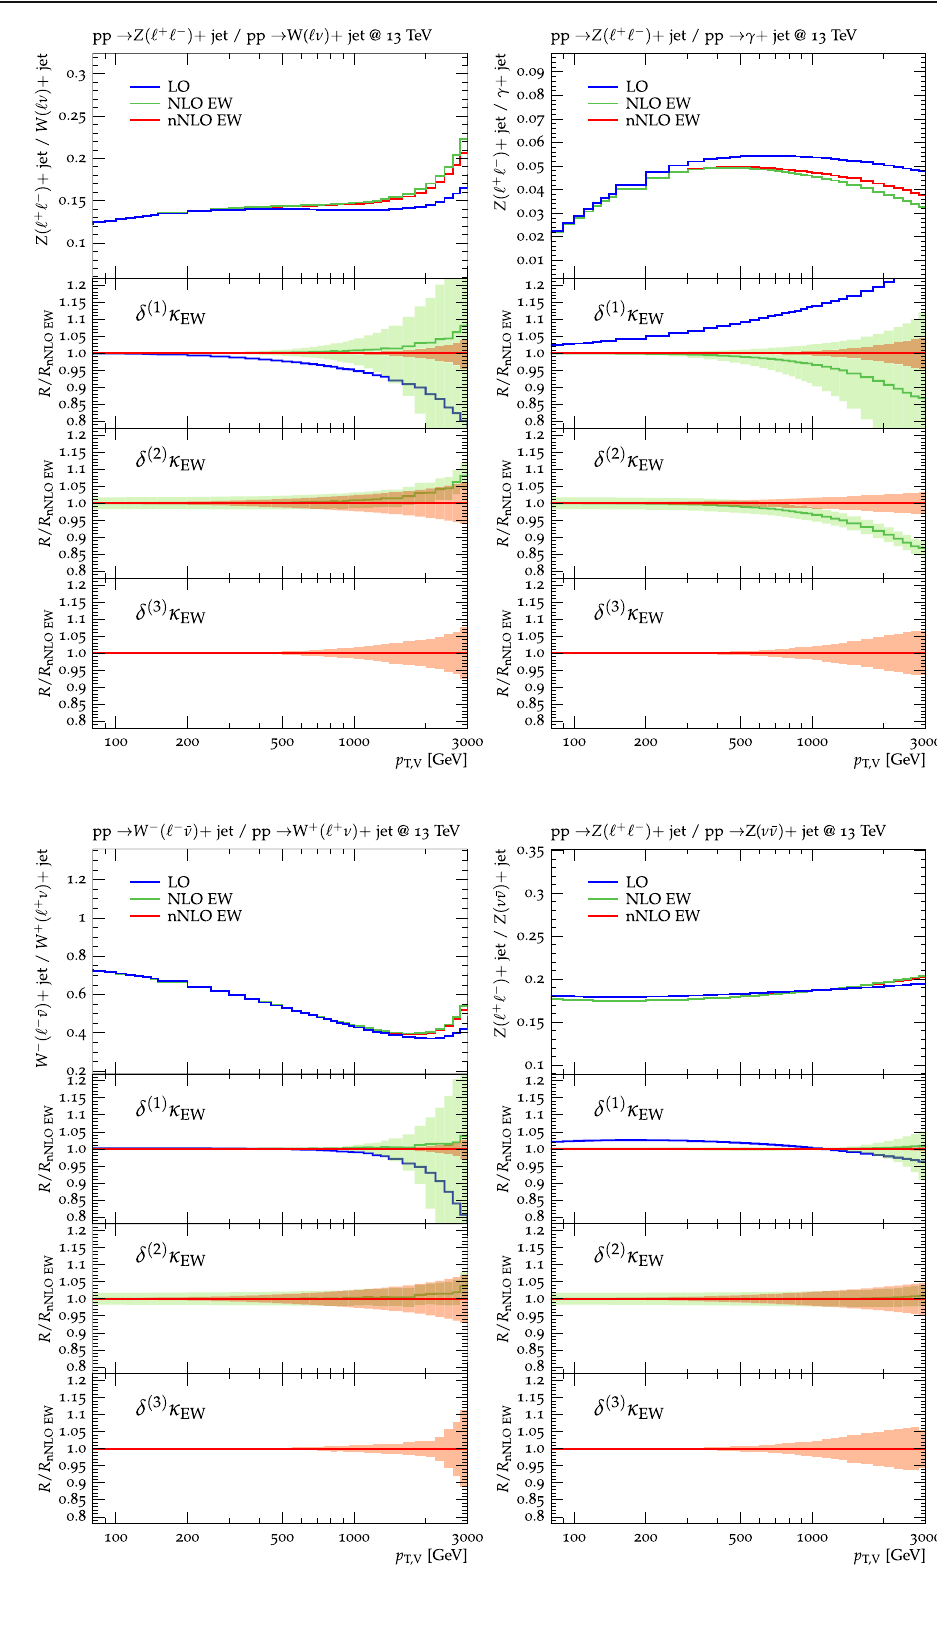
Fig. 21 Ratios of p T -distributions for various pp → V + jet processes at LO, NLO EW and nNLO EW. The related EW uncertainties, δ ( i ) κ ( V ) , are defined EW in Eqs. (52), (53) and (56) at nNLO and in Eq. (57) at NLO. ( V ) The uncertainty δ ( 1 ) κ is EW correlated amongst processes, ( V ) ( V ) while δ ( 2 ) κ and δ ( 3 ) κ are EW EW